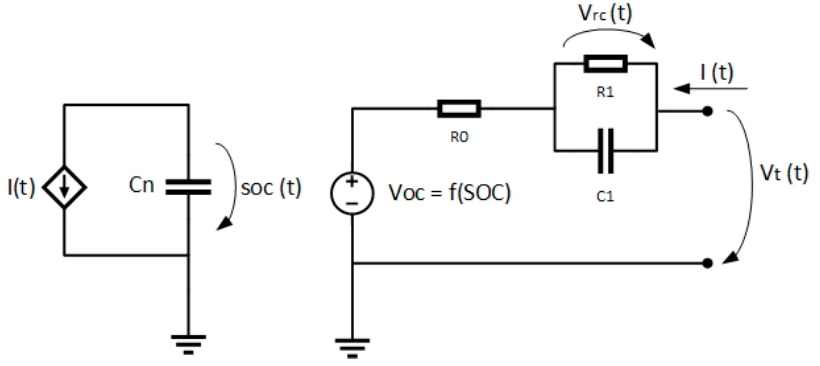
Figure 1. Equivalent circuit model for a lithium-ion battery pack.